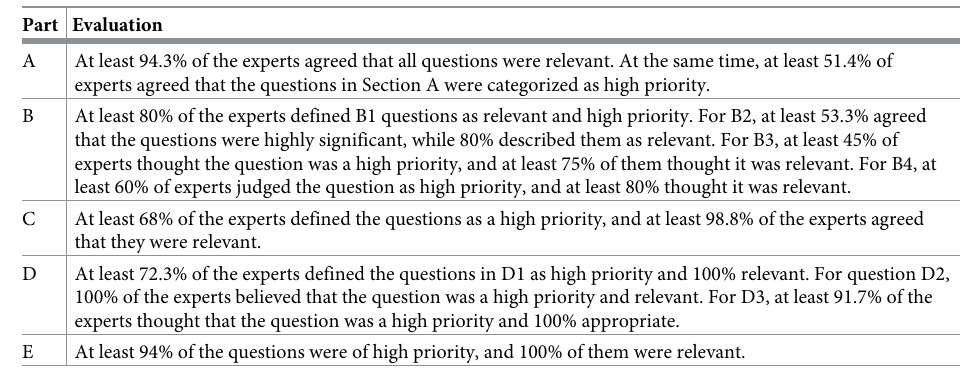
Table 4. Summary of expert